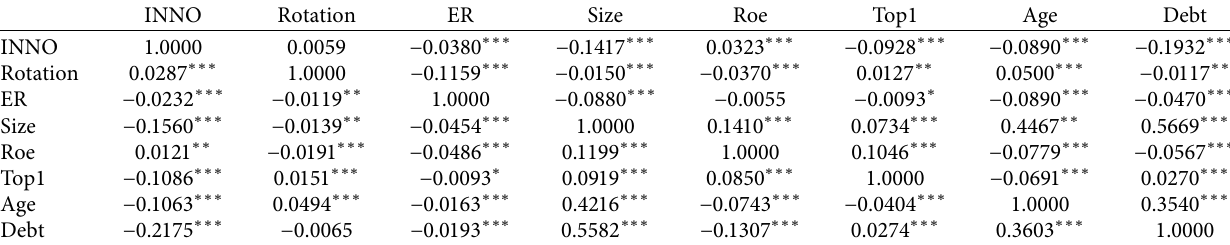
Table 7: Main variable correlation coefficient